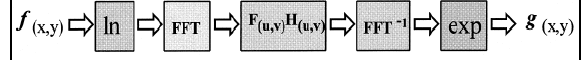
Figure 3. Flowchart of homomorphic filter (Adelmann,